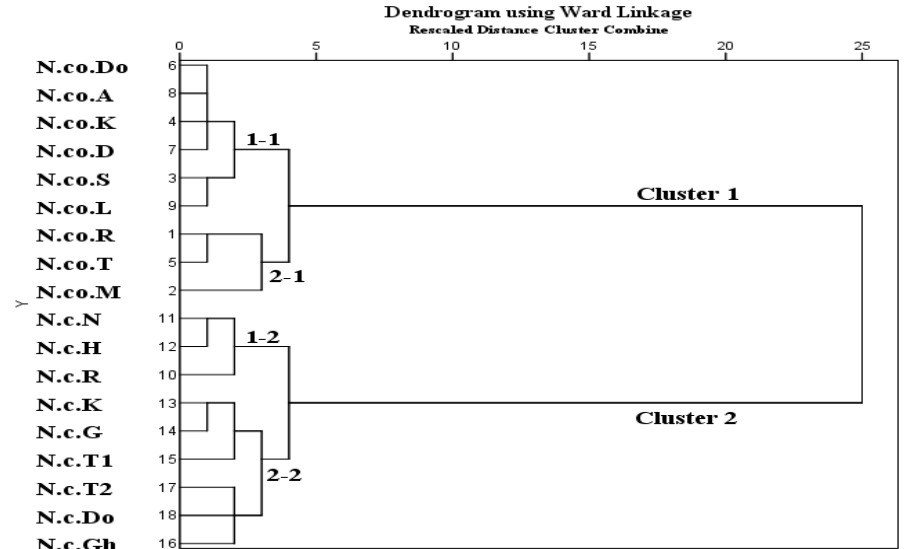
Fig. 2. Morphometry relationship among Neckera genus: Numbers above branches are wards support values as estimated by the morphological cladistic analysis. This simplified strict consensus tree depicts the position of N. complanata and N. crispa as separate